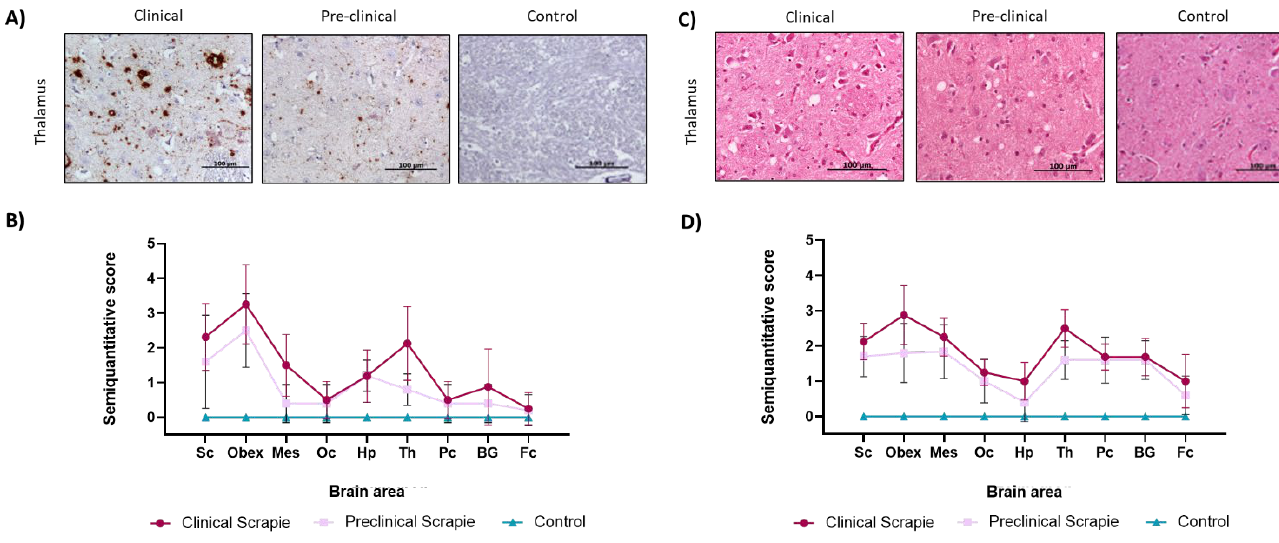
Figure 3. PrP Sc deposition and spongiform changes in the brains of clinical ( n = 8), preclinical ( n = 5), and control ( n = 8) sheep. ( A ) Representative images of PrP Sc deposits detected by immunohisto- chemistry in the obex and thalamus of the three groups of sheep. ( B ) Graphics showing comparisons of the semiquantitative evaluation (on a scale of 0—lack of staining—to 5—staining present at max- imum intensity) of these deposits and representing the mean ± SEM in the following areas: spinal cord (Sc), mesencephalon (Mes), occipital cortex (Oc), thalamus (Th), hippocampus (Hp), thalamus (Th), parietal cortex (Pc), basal ganglia (BG), and frontal cortex (Fc). ( C ) Representative images of hematoxylin and eosin staining in the obex and thalamus of clinical, preclinical, and control sheep. ( D ) Graphic results of the semiquantitative evaluation (on a scale of 0—lack of spongiosis—to 5—very intense spongiosis) of these lesions in the three sheep groups, representing the mean ± SEM, in the previously mentioned areas: spinal cord (Sc), mesencephalon (Mes), thalamus (Th), hippocam- pus (Hp), thalamus (Th), parietal cortex (Pc), basal ganglia (BG), and frontal cortex (Fc).